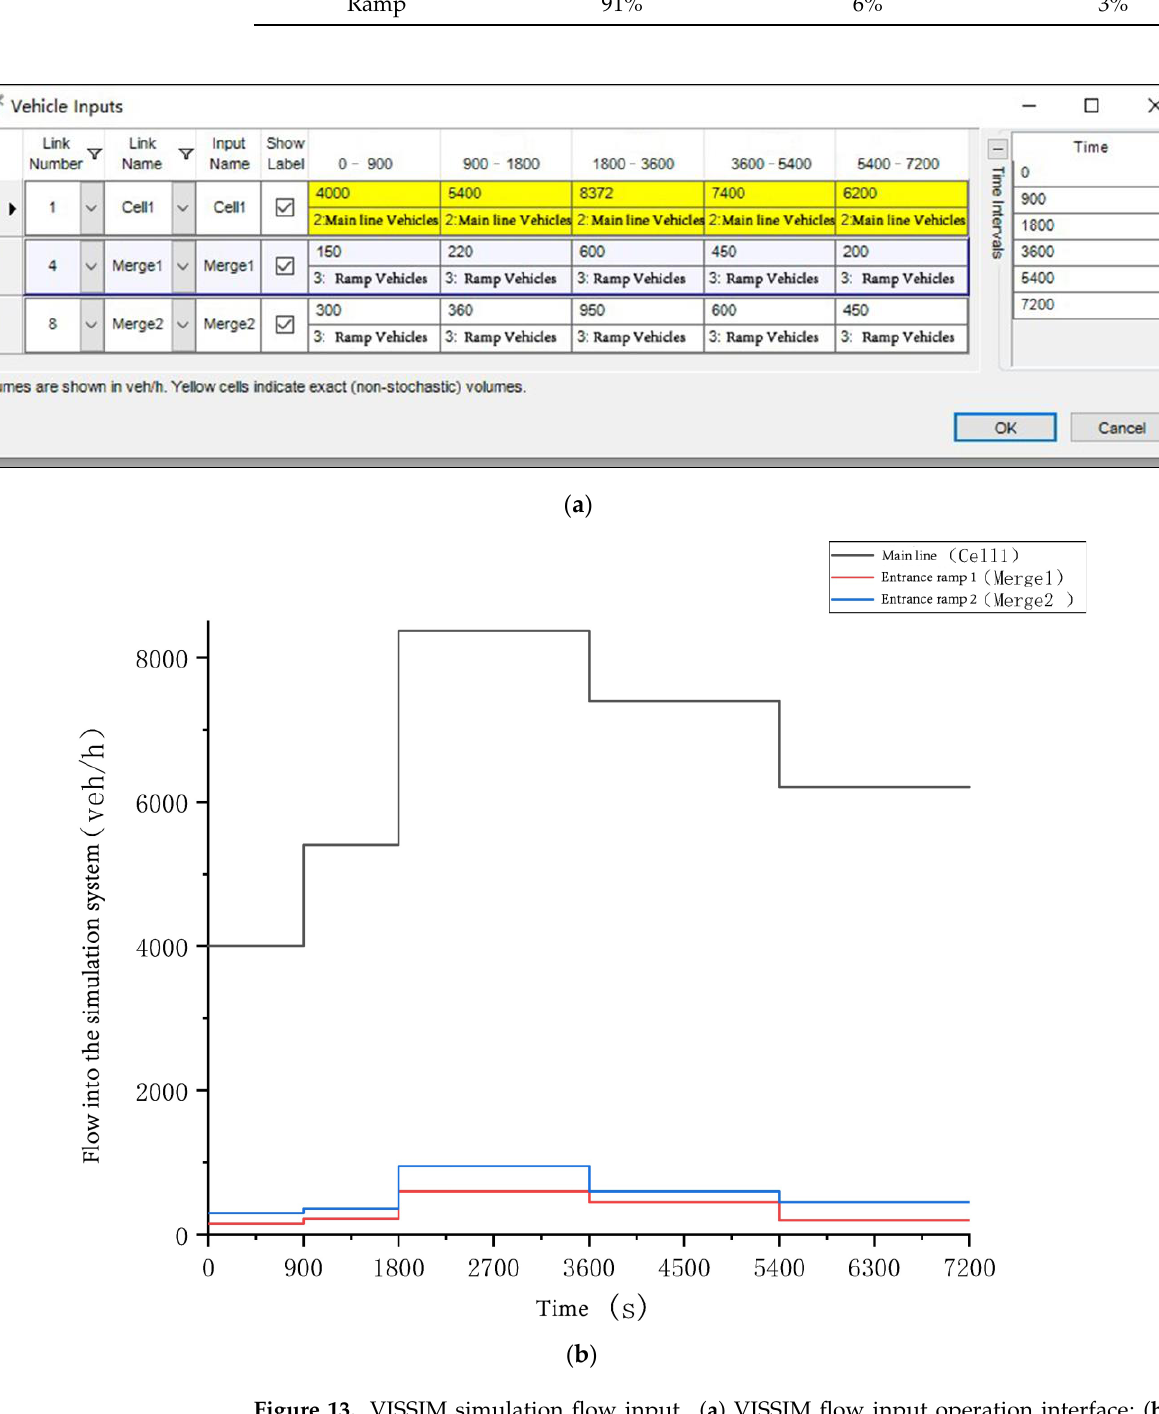
Figure 13. VISSIM simulation flow input. ( a ) VISSIM flow input operation interface; ( b ) Input flow distribution.